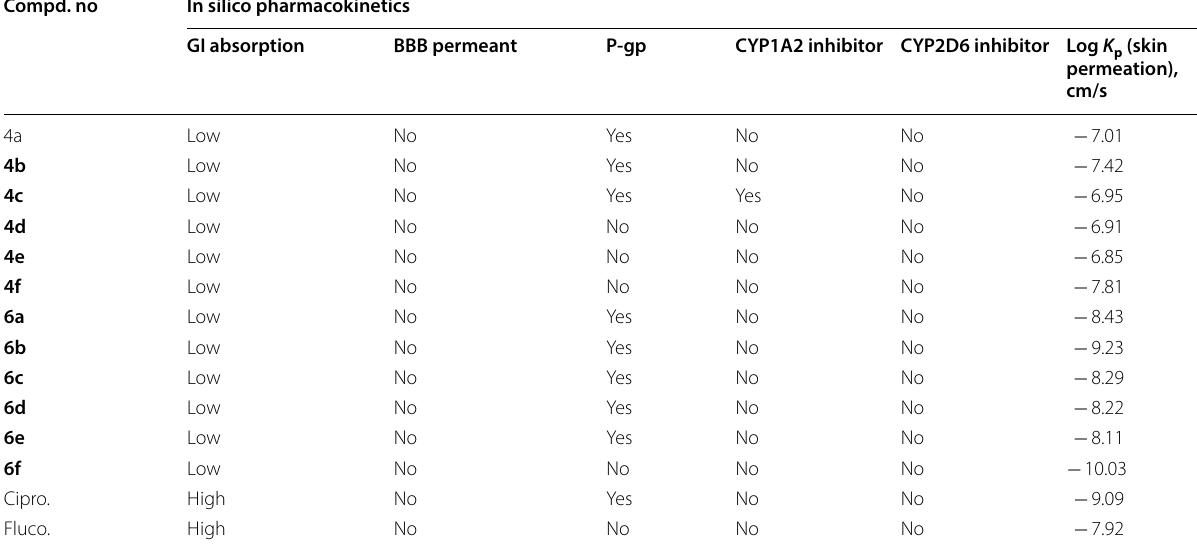
GI, gastro intestinal; P‑gp, P‑glycoprotein; BBB, blood brain barrier; CYP1A2, cytochrome P450 family 1 subfamily A member 2 (PDB: 2HI4); CYP2D6, cytochrome P450 family 2 subfamily D member 6 (PDB: 5TFT)